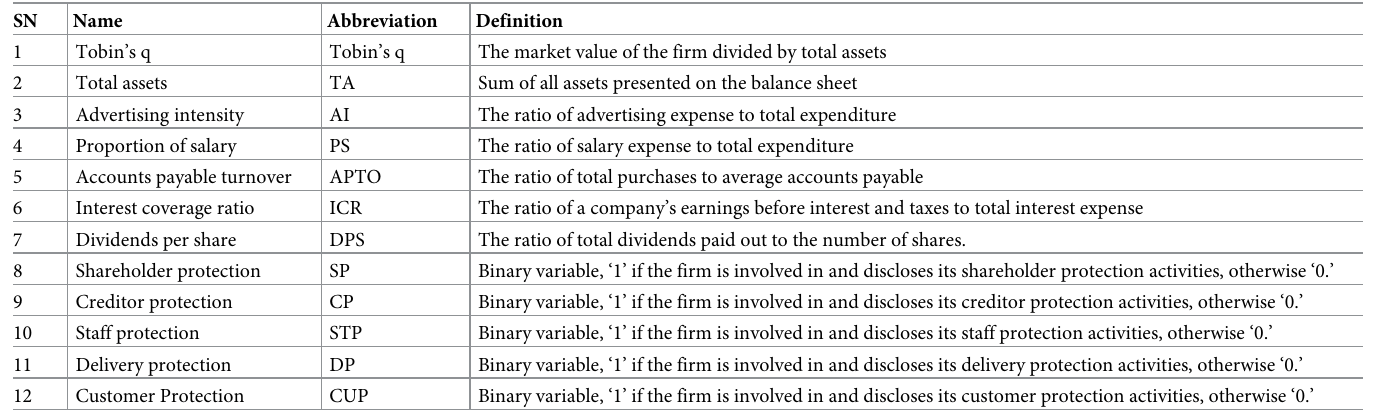
Table 2. Variable construction.